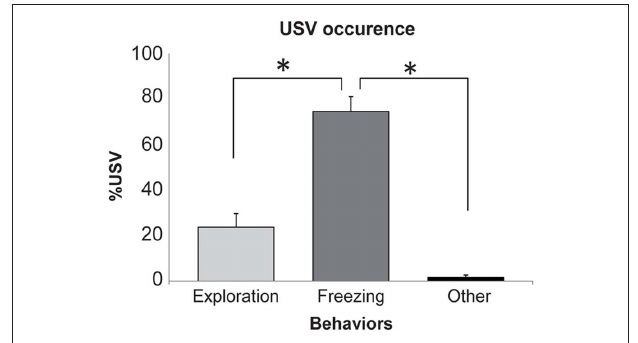
Figure 2 | Occurrence of ultrasonic vocalizations (uSV) in the different behaviors. For each behavior, the duration of USV was expressed as a percent (mean ± SEM) of the behavior total duration. *Significant difference ( p > 0.001).